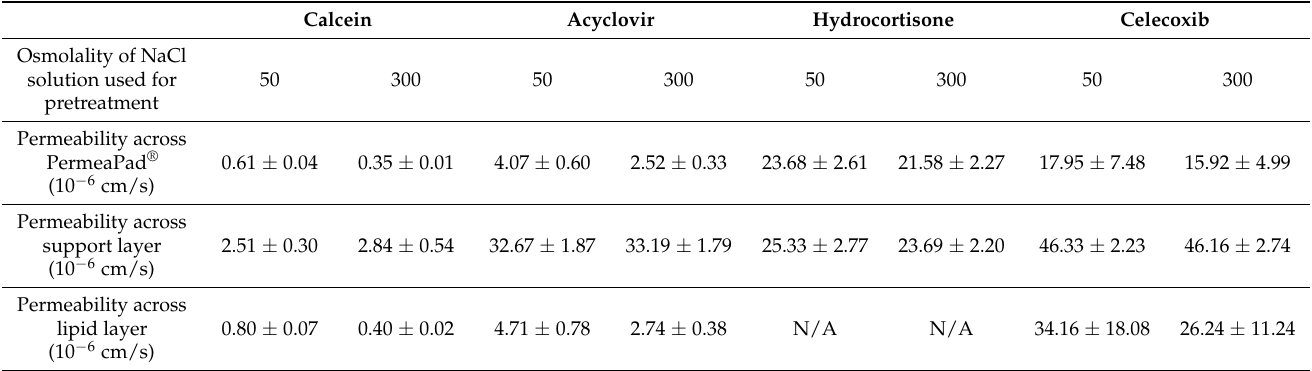
Table 2. Apparent permeability values of model compounds across PermeaPad ® , the support layer, and the lipid layer. Calcein Acyclovir Hydrocortisone Celecoxib